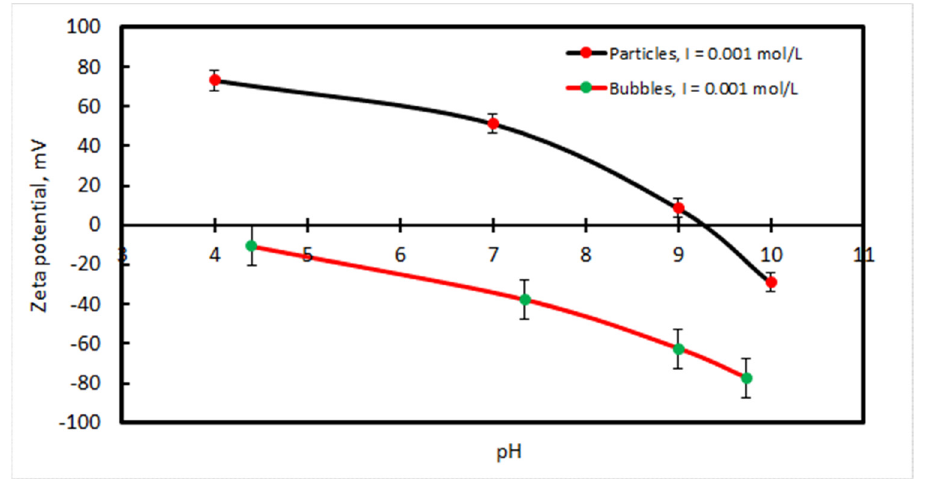
Figure 2. Zeta potential of modified silica particles and microbubbles [53] versus pH at I = 10 − 3 mol/L. The graphic of the zeta potential of bubbles is reproduced with the permission of Elsevier with license number 5372051222249.